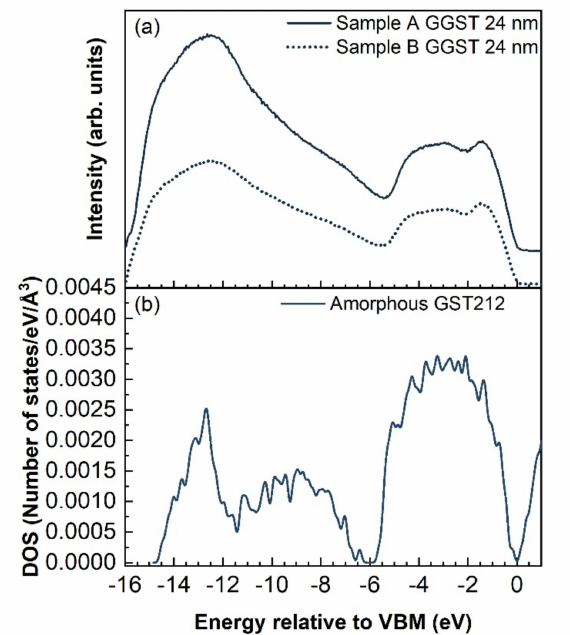
Figure 5. Comparison between ( a ) UPS spectra acquired on the two heterostructures after deposition of 24 nm of GGST and ( b ) DFT calculations of the DOS of amorphous GST212.